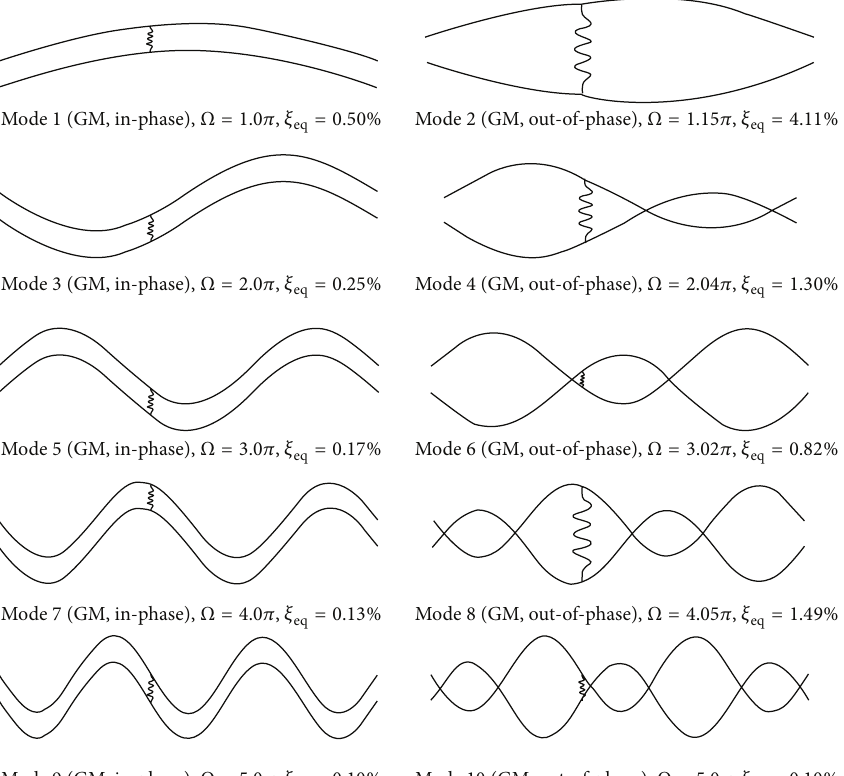
Figure 3: First ten modes of a twin-cable network with a damped flexible cross-tie ( 𝐾 𝑐 = 30.54 kN/m, 𝐶 𝑐 = 1.0 kN ⋅ s/m) at 𝜀 = 2/5